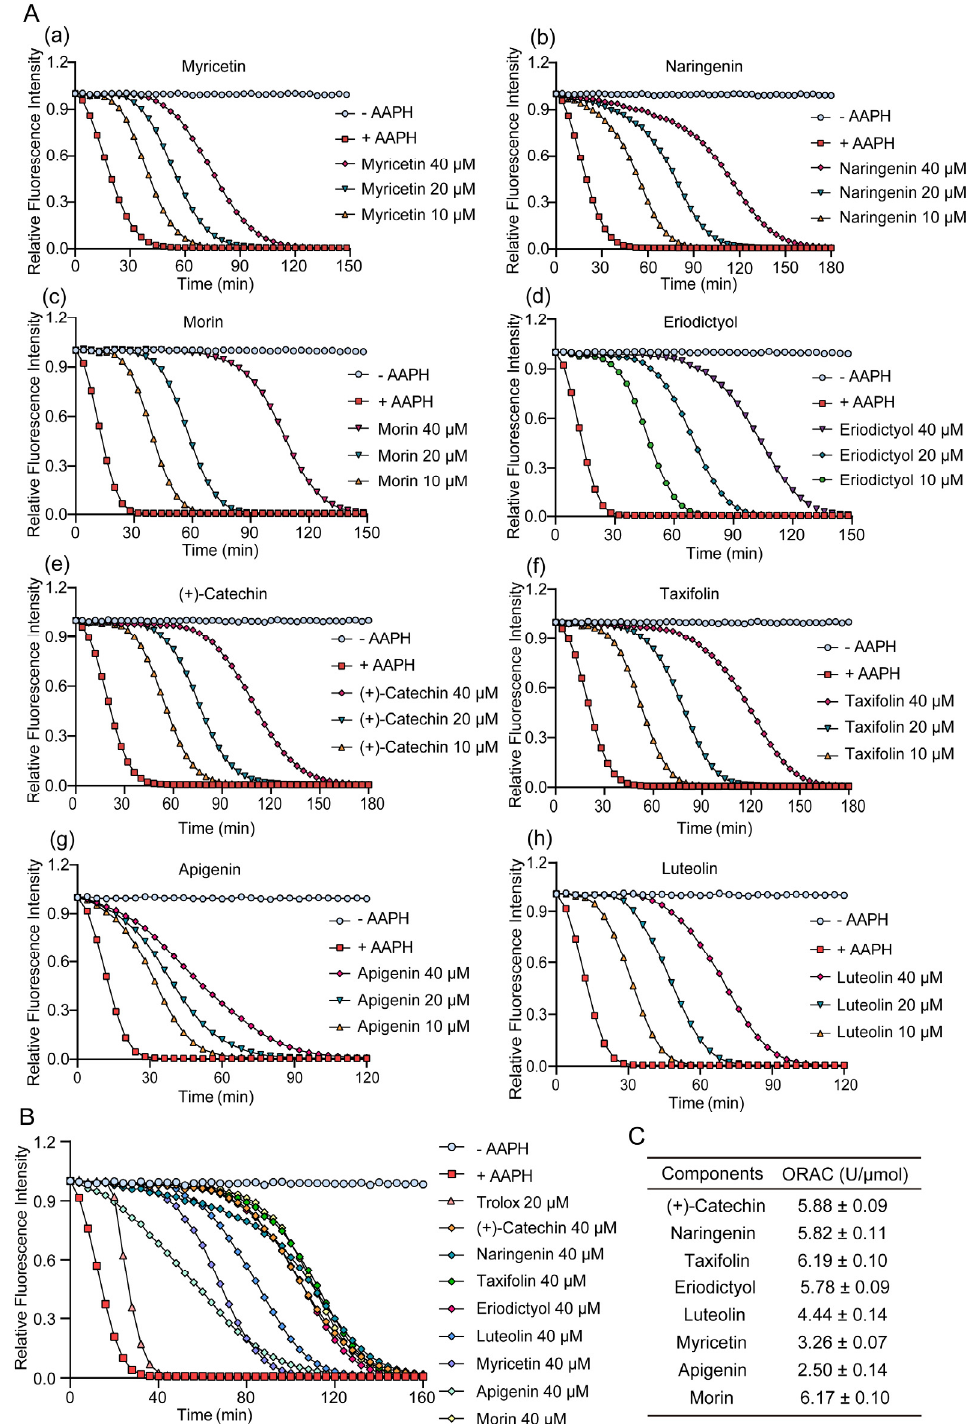
Figure 2. Inhibition effects of eight flavonoids on fluorescence decay in vitro. ( A ) Fluorescence signal attenuation curves of eight flavonoids in TSE, from ( a – h ) as followed myricetin, naringenin, morin, eriodictyol, (+)-catechin, taxifolin, apigenin, luteolin and respectively. n = 6. ( B , C ) The fluorescence signal attenuation curves and the ORAC values of 8 flavonoids at concentration of 40 μ M. n = 6. The ROS scavenging capacity of eight compounds were detected by ORAC, using AAPH as a ROS generator, and the antioxidative activity was calculated as ORAC (U/ μ mol).